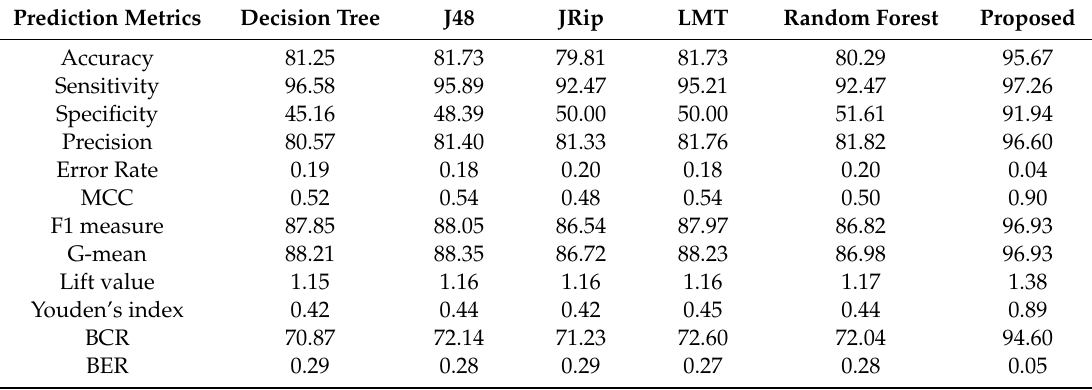
Table 10. Shape and Colour